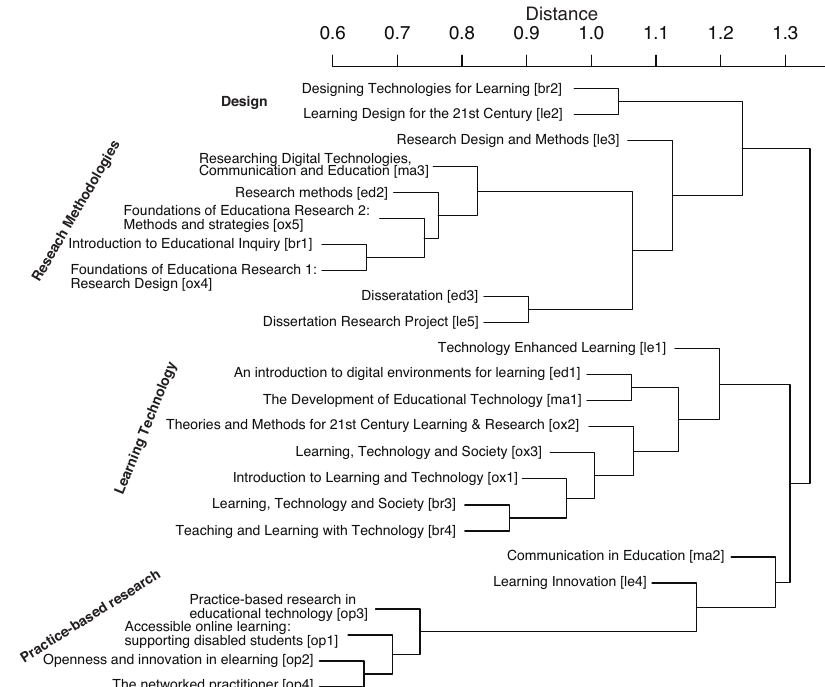
Figure 3. A dendrogram of subjects which are described as syllabi at UK universities